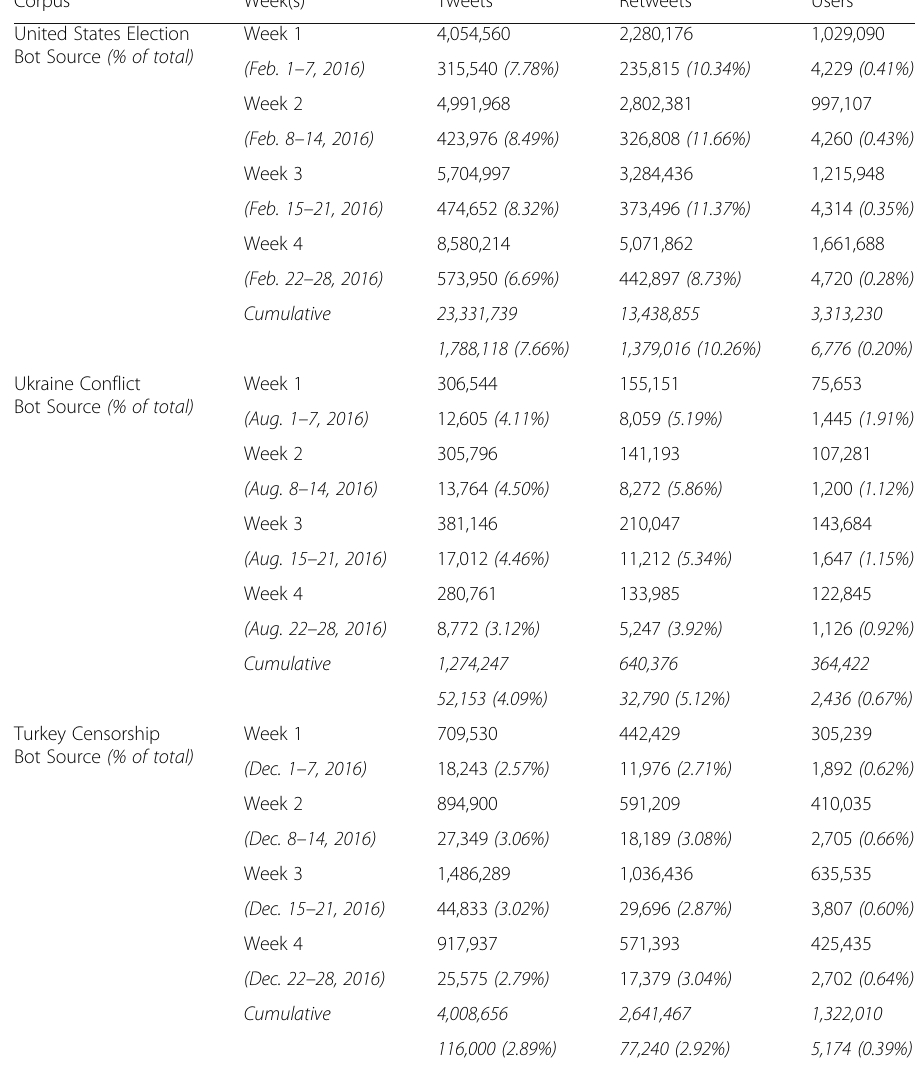
Table 2 Twitter corpus overview at the weekly and cumulative perspective for each OSN conversation in this study Corpus Week(s) Tweets Retweets Users United States Election Bot Source (% of